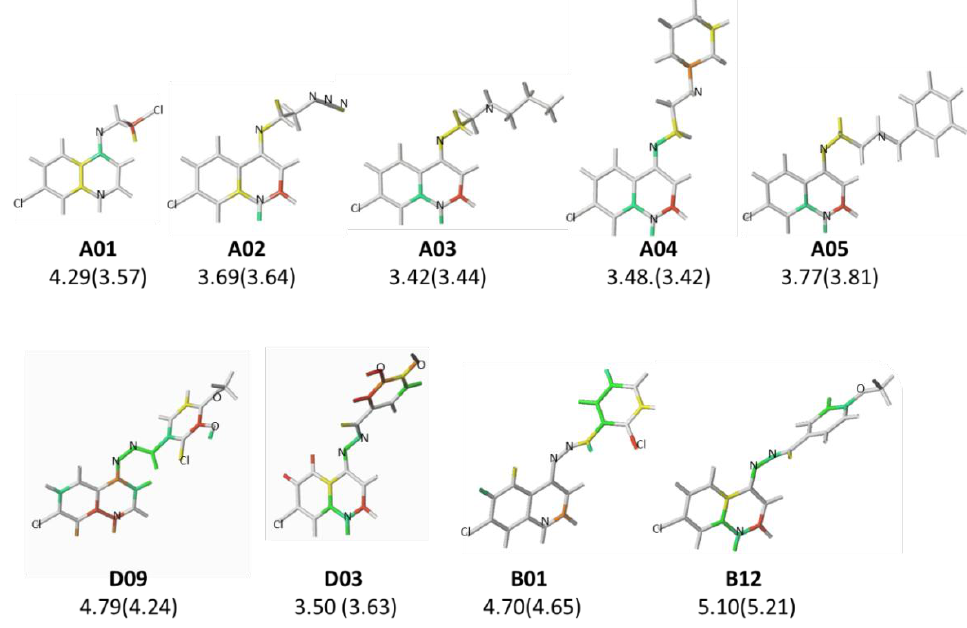
Figure 4. The HQSAR contribution maps of the outliers ( A01 and D09 ) and similar compounds that belong to the training set.